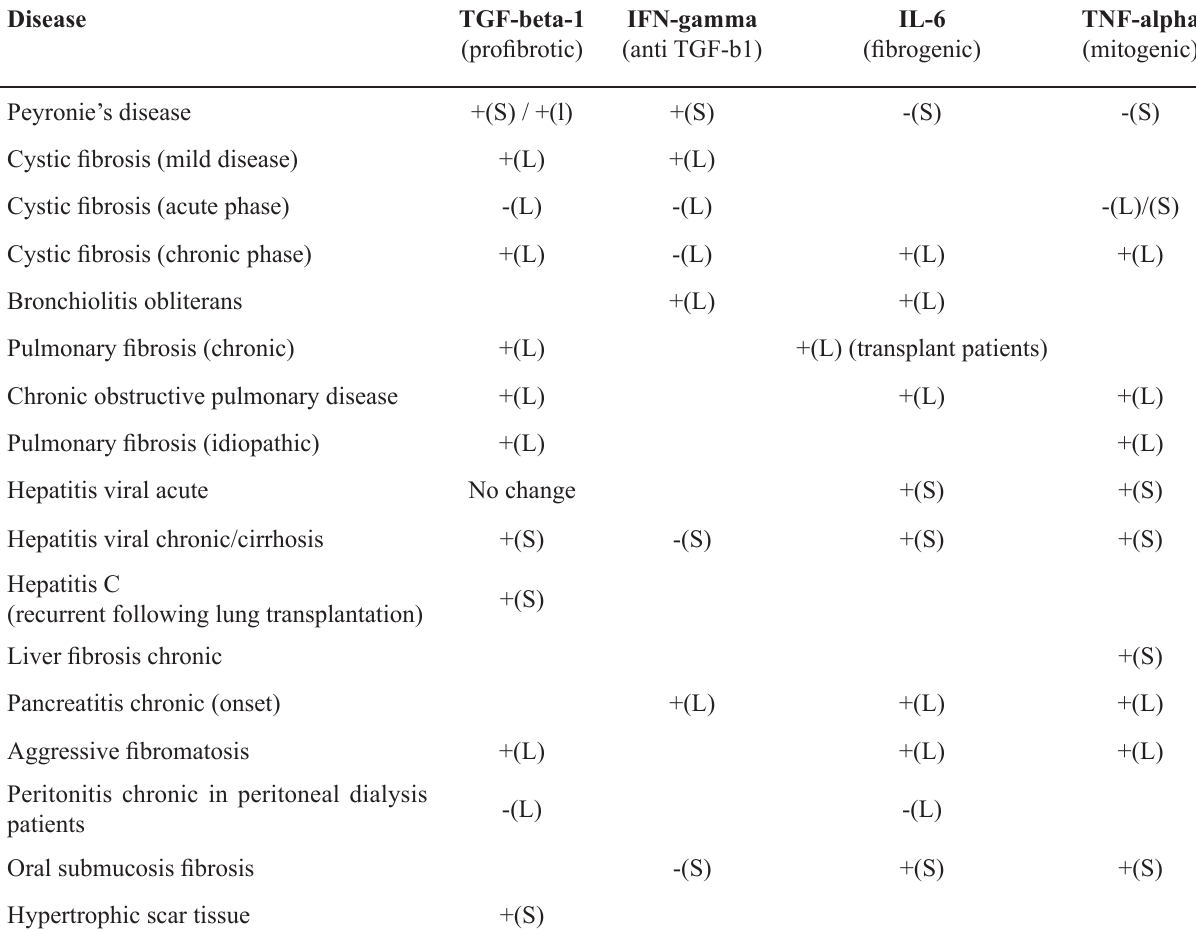
Table 3 – Local and systemic cytokine alterations in various fibrosis-associated diseases.